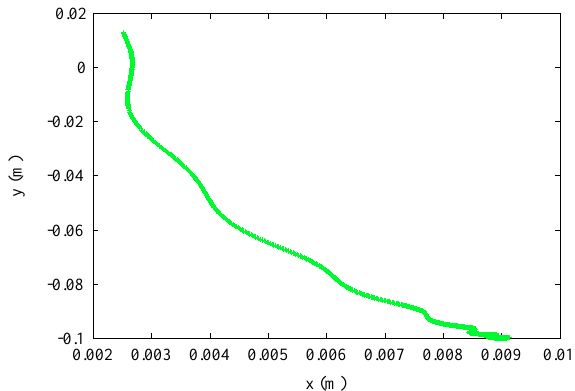
FIG. 8. (Color) Tracking through an adiabatic coupler. The particle starts at (cid:121) (cid:173) 2 (cid:48)(cid:46)(cid:49) m and moves slowly to its equi- librium offset over many Larmor lengths without exciting large cusp